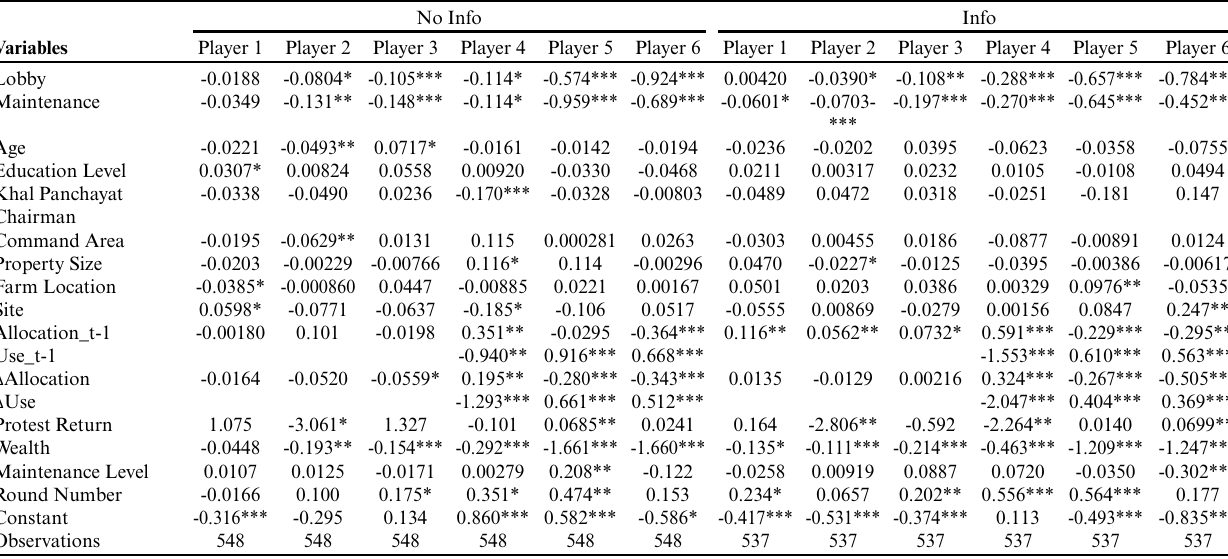
Table 3 . Player-by-player regressions: protest